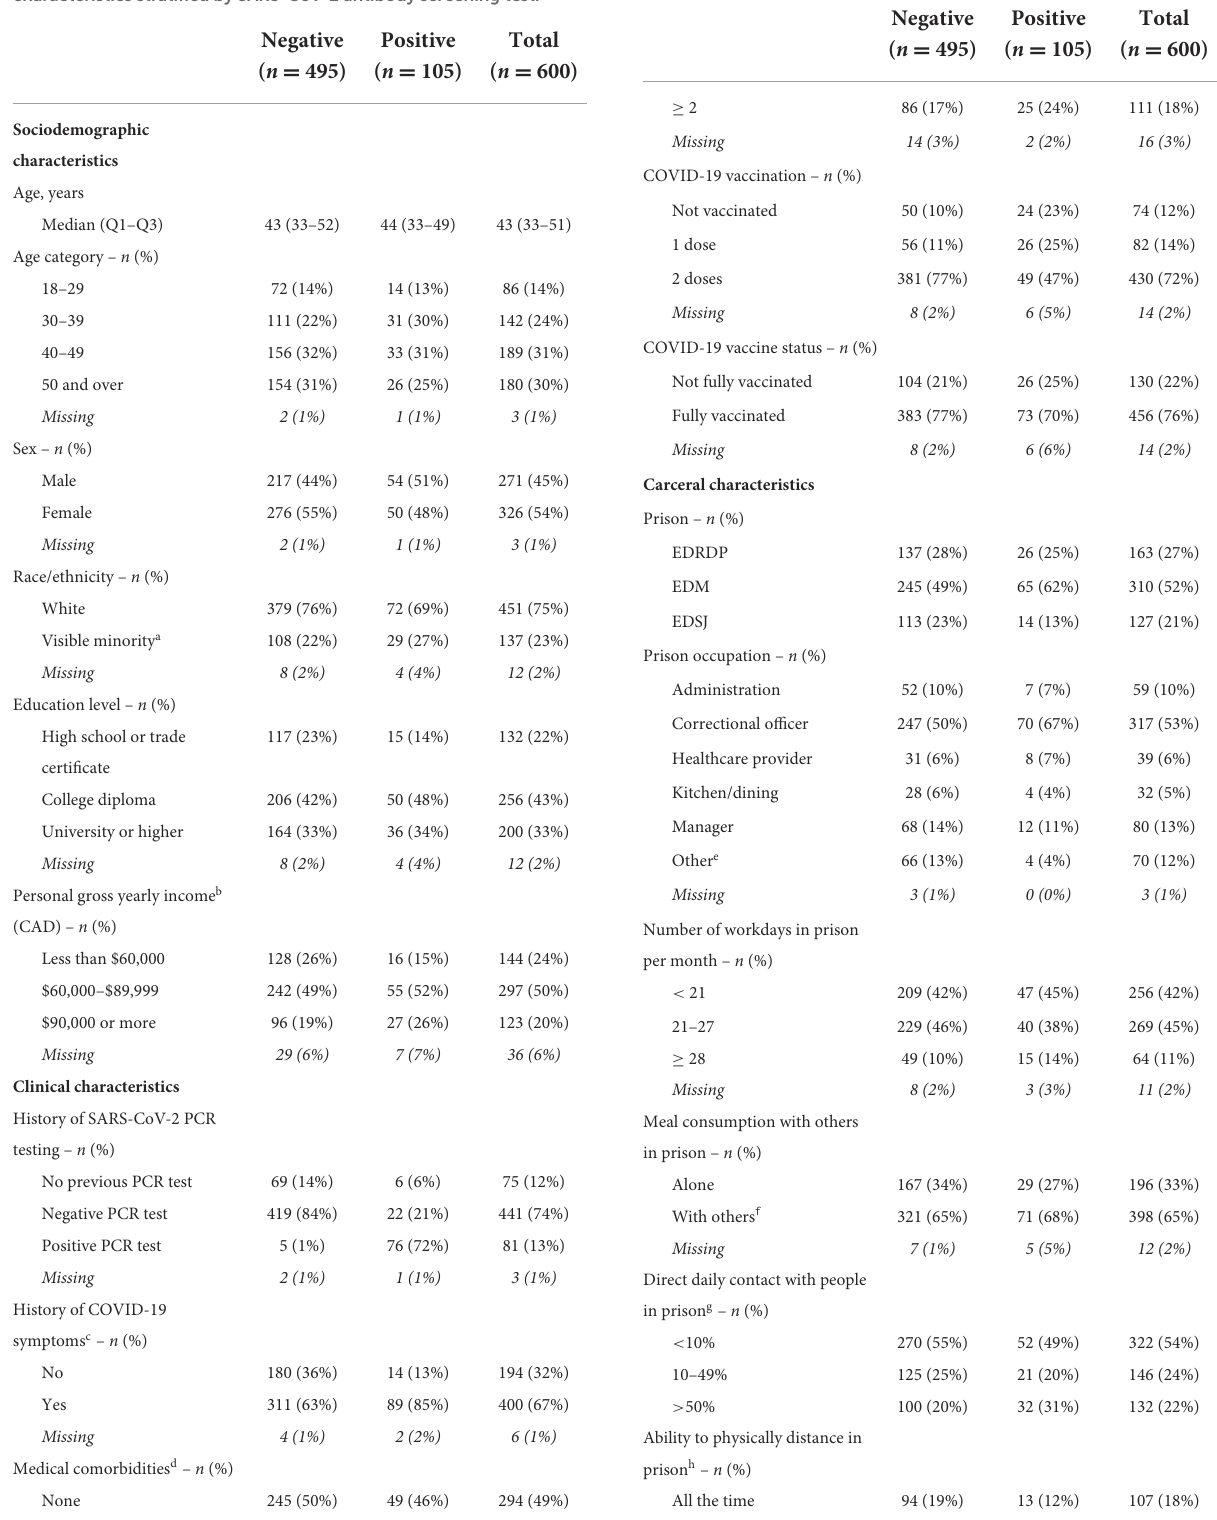
TABLE 1 Participants’ socio-demographic and behavioral characteristics stratified by SARS-CoV-2 antibody screening test.